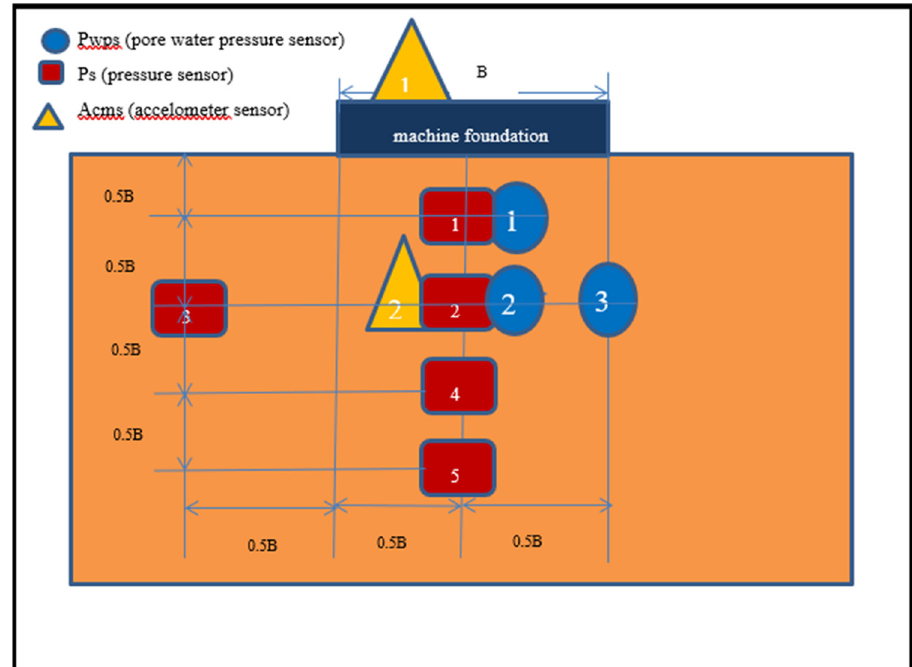
Figure 3: Distribution of sensors inside the